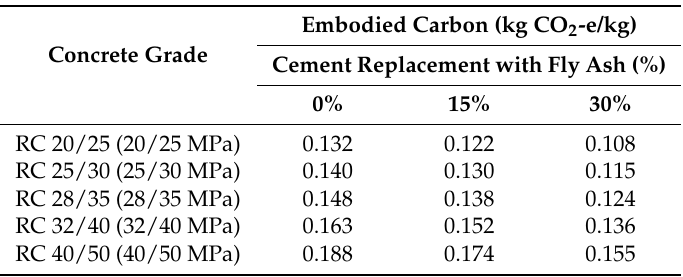
Table 1. Effect of fly ash replacement for Portland cement on embodied carbon of concrete.